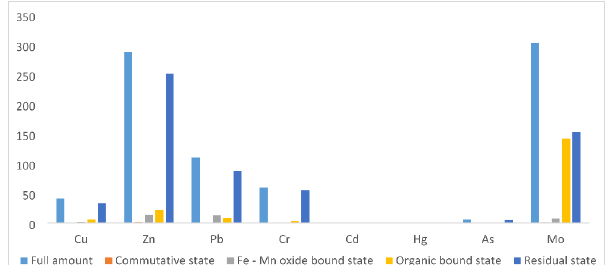
Fig. 3 Content of various forms of heavy metals in the soil of farmland around waste dumps at the study site